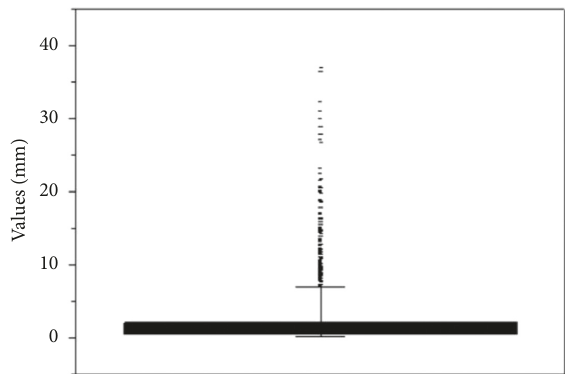
Figure 1: The standard boxplot of hourly rainfall datasets from Wuyigong Station.